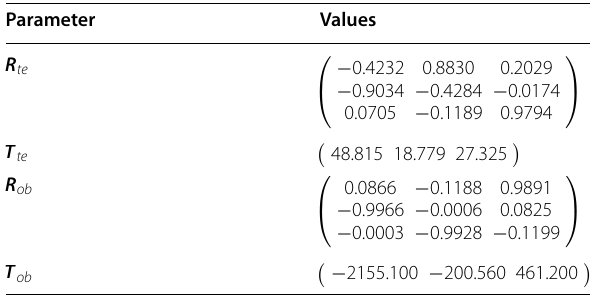
Table 3 The results of system calibration.